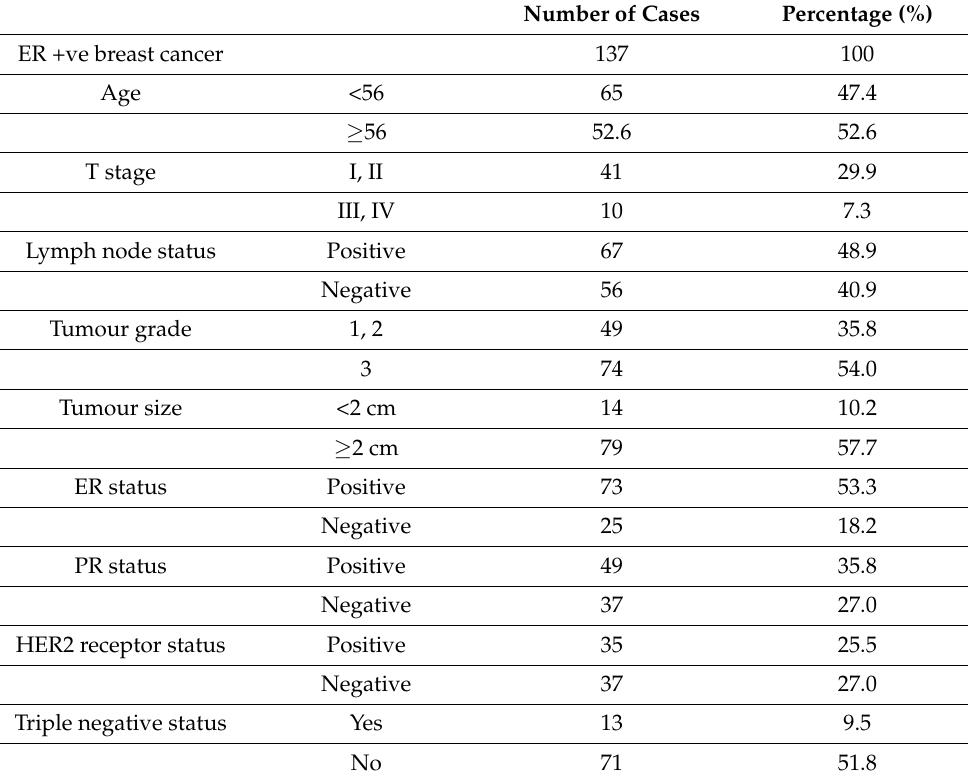
Table 2. Clinical information about breast cancer